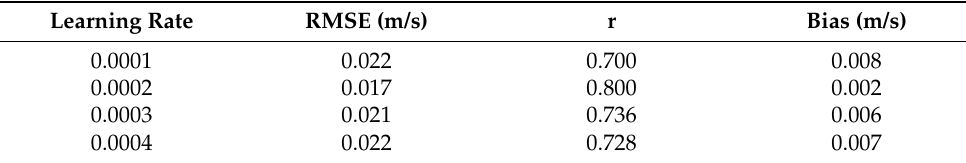
Table 7. Statistics of the estimation results under different learning